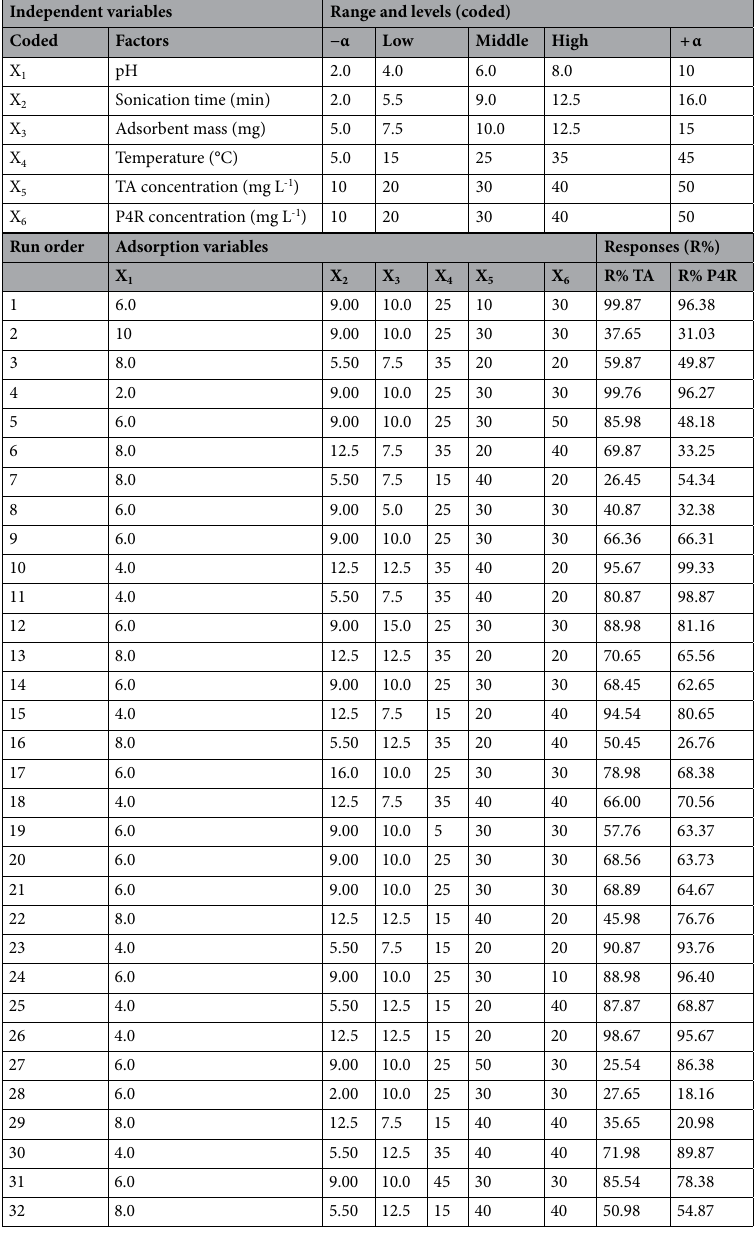
Table 1. Experimental design matrix using RSM-CCD and average responses for adsorptive removal of TA and P4R dyes by